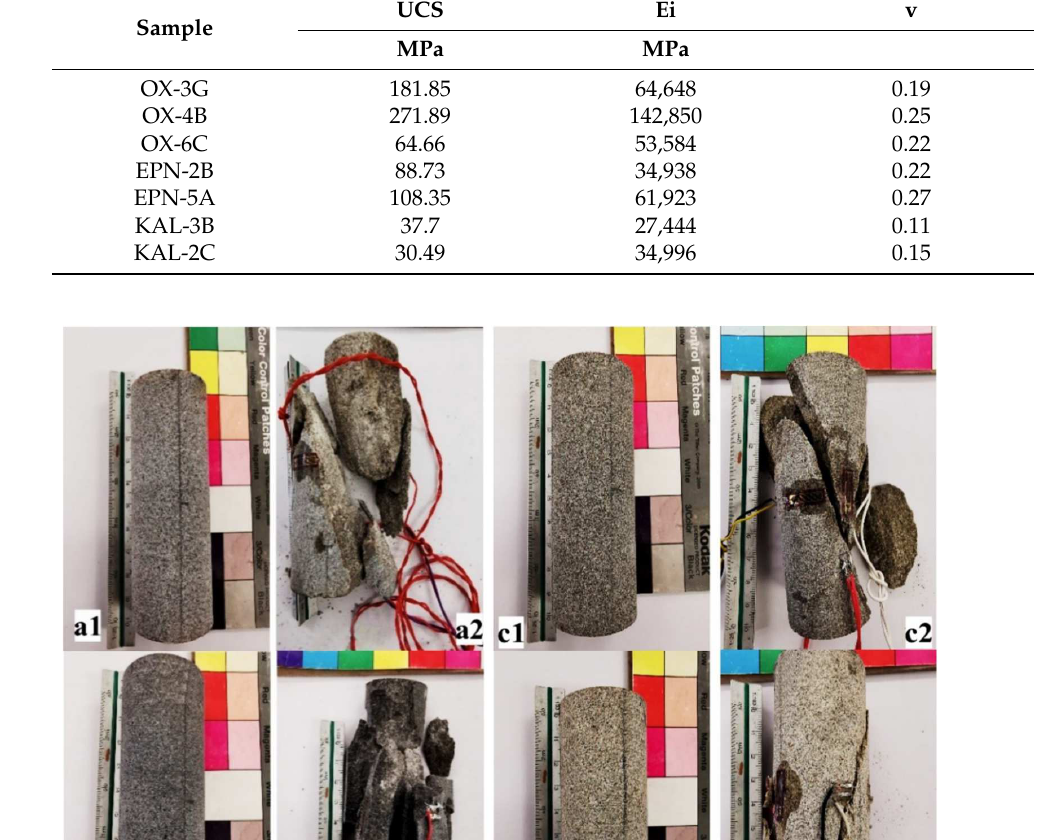
Figure 9. Typical breaks in cylindrical specimens under uniaxial compressive strength before and after the testing of the corresponding samples. ( a1 , a2 ) (sample OX-6C), ( b1 , b2 ) (sample OX-4B) are from Pentalofos Formation sandstones; ( c1 , c2 ) (sample KAL-3B) from Southern Eptachori